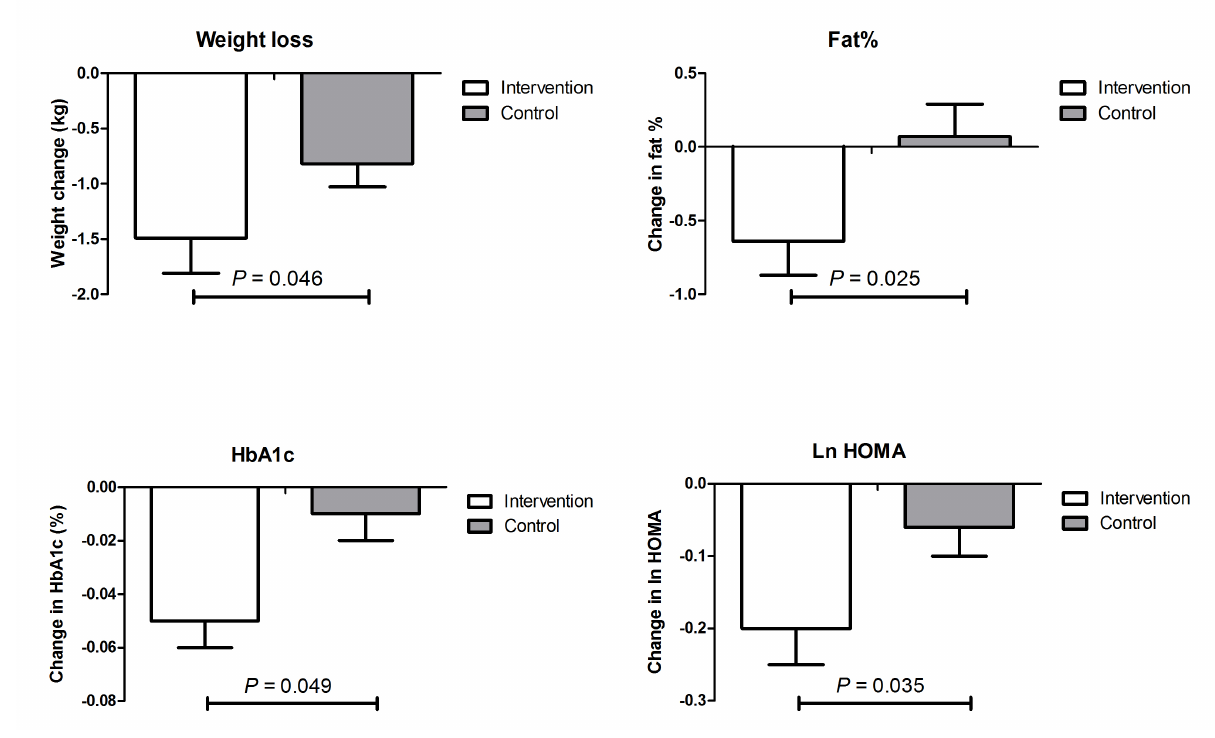
Figure 3. Changes in a selection of metabolic